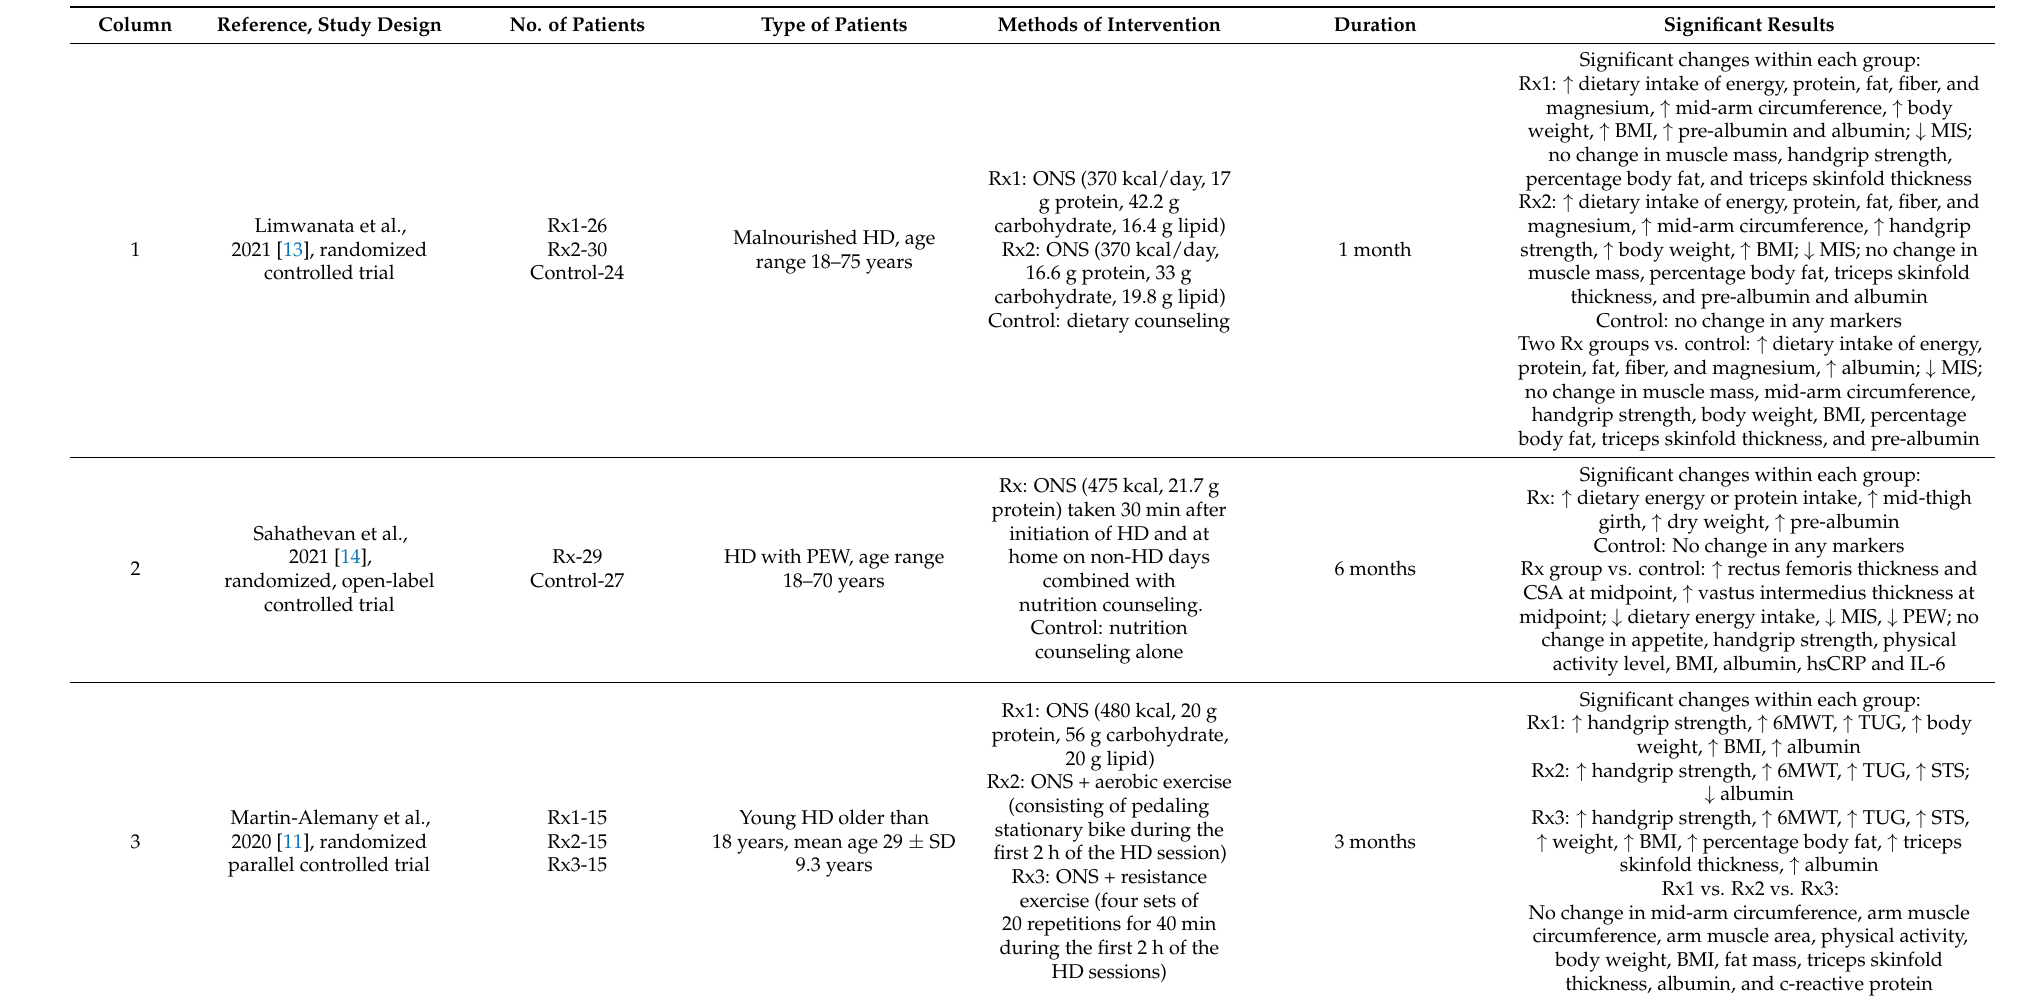
Table 1. The effects of nutritional support with or without exercise training on body composition, exercise capacity, physical performance, and proinflammatory cytokines in advanced CKD